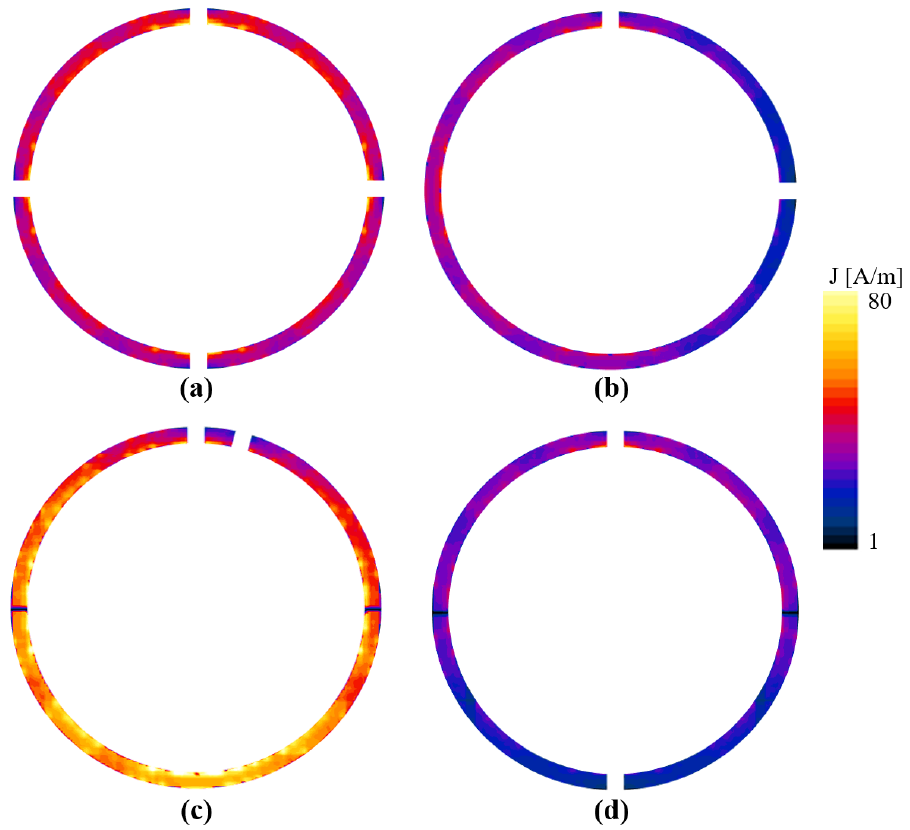
Figure 4. Current densities of ( a ) reference coil, and of coils with capacitor positioned at ( b ) 15°, ( c ) 90°, and ( d ) 180°.